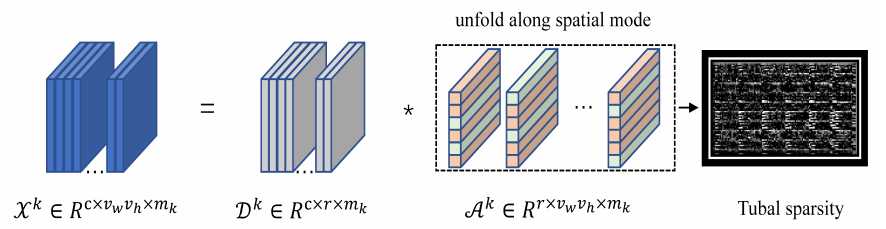
Figure 4. Tubal row-sparse constraints for coefficient tensor, the red tubes in the coefficient tensors stand for the non-zero tubes, and green ones are zero tubes. The image on the far right is the visualization matrix of A k expanded along the second